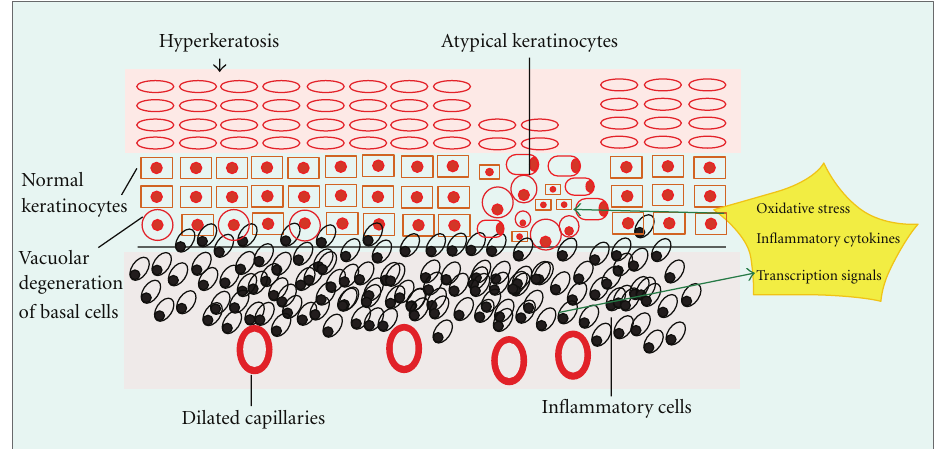
Figure 1: The current hypothesis on the development of dysplasia and cancer in OLP suggests that changes in epithelial cells (keratinocytes) is a result of detuning in cellular replication, DNA damage and disorganization of epithelial integrity, secondary to oxidative stress, cytokine, and transcription factor signals originating from the inflammatory